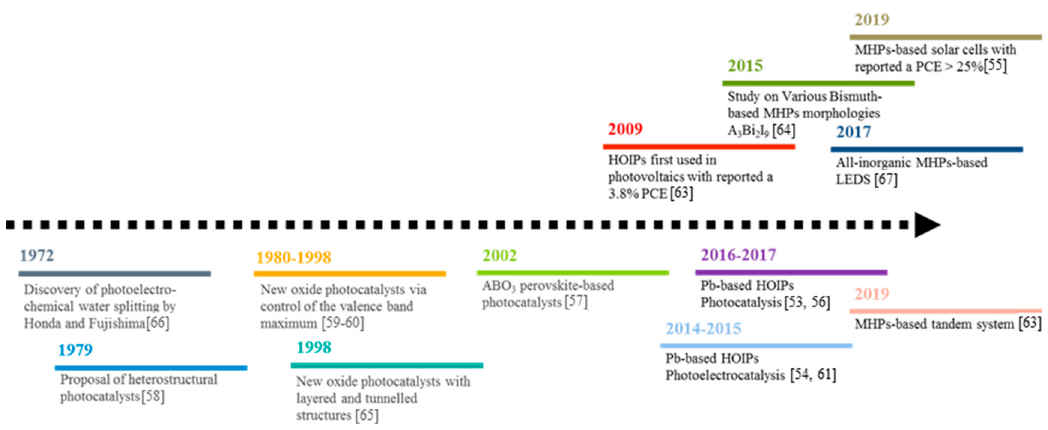
Figure 1. Timeline of progress in photocatalysis and metal halide perovskite-based materials.